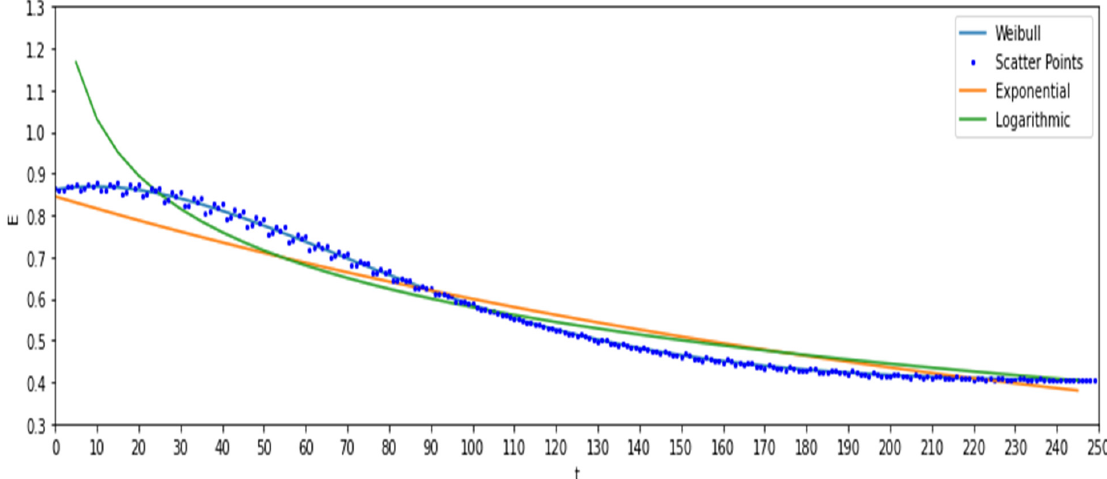
Figure 14. Fitting curves of the statistical analysis data at 250 measurement points.